Question: Give a one-sentence summary of this figure.
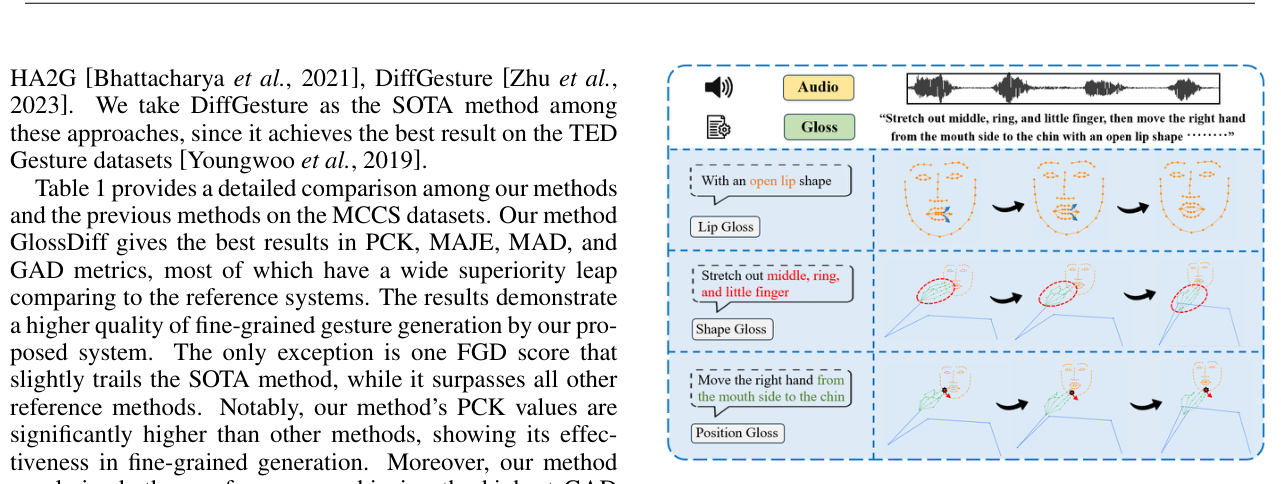
Answer: The visualization result of the generated gesture according to fine-grained Gloss. Better view by zooming in.